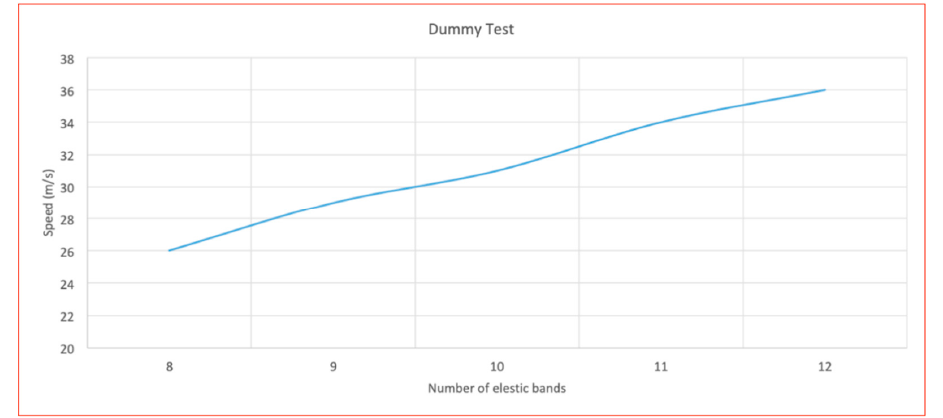
Figure 25. Dummy launching speed test.